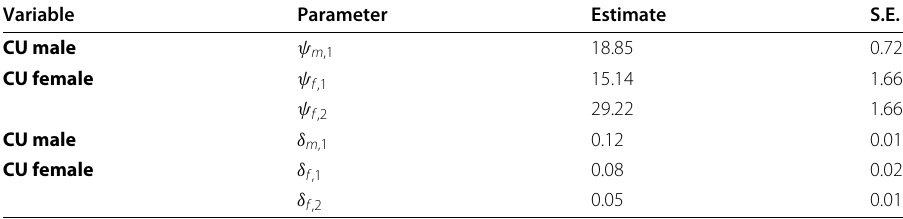
Table 3 Parameter estimates of the ψ ’s and δ ’s of the segmented regression model